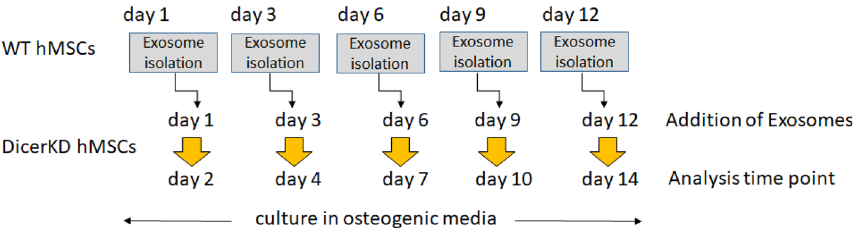
Figure 7. Schematic of experimental design for exosomal complementation study: WT hMSC cultures were initiated 24 h prior to DicerKD and AGO2KD cultures. At designated times, WT hMSCs were grown 24 h in serum free media before collection of media for isolation of WT hMSC exosomes. The following day, WT hMSC exosomes were added to DicerKD and AGO2KD cultures. The cells were harvested at day 1 and after 7 or 14 days for analysis of osteoblastic gene expression and culture